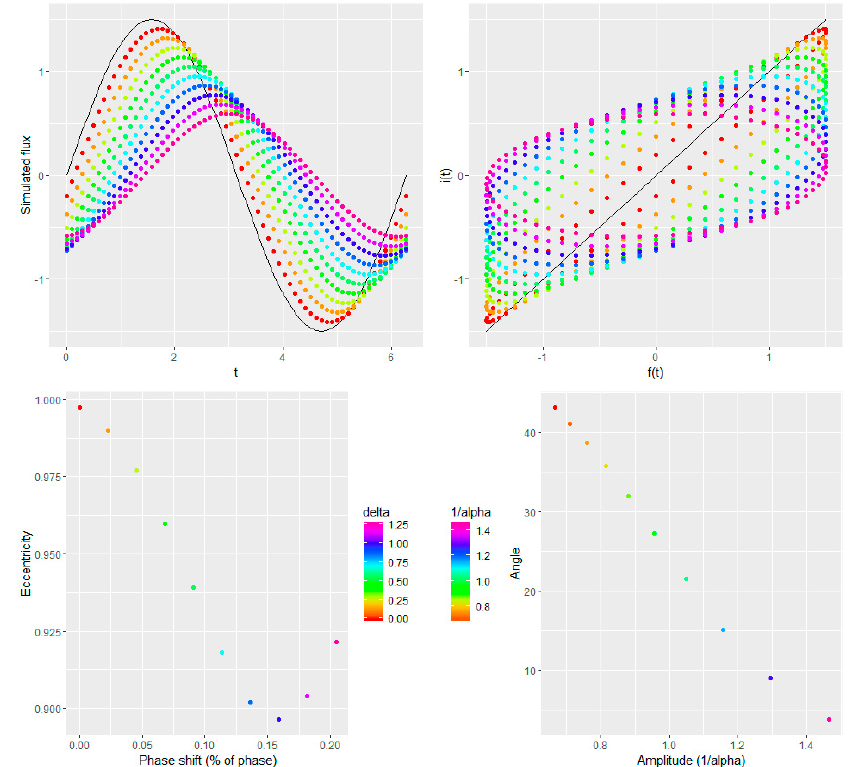
Figure 5. Idealized system response when both phase shift and magnitude modifiers are applied. Upper : parametric functions and incremental changes in modified response functions are shown left, and event-response ellipses are shown right. Lower : relations of eccentricity to phase shift are shown left and angle to amplitude are shown right.